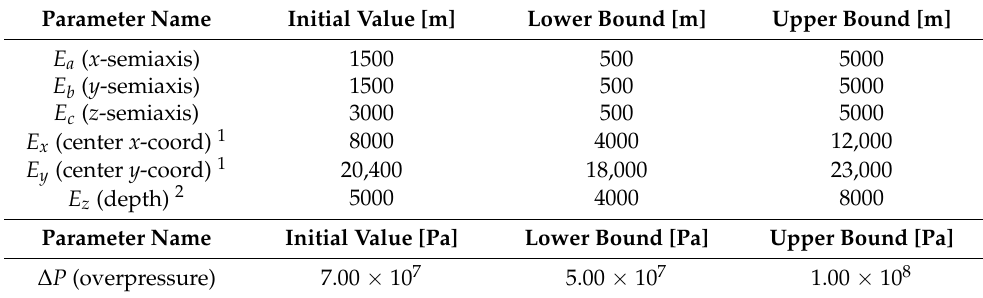
Table 2. Initial values and ranges of the parameters used in the FEM model